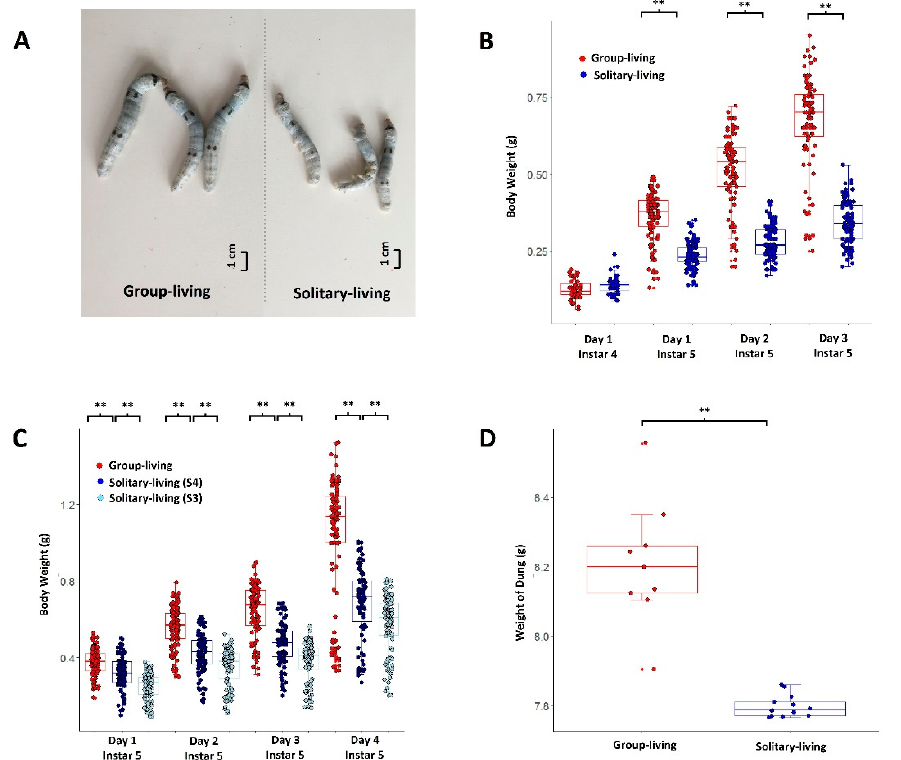
Figure 1. Evidence showing that solitary-living silkworms experienced a loss of body weight compared to group-breeding silkworms. ( A ) is a photo showing the difference in appearance of solitary and group-living silkworms in the 3rd day of the 5th instar. ( B ) shows the body weights of solitary (blue) and group-living (red) silkworms from the 1st day to the 3rd of the 5th instar. The weights on the 1st day of the 4th instar acts as a control for comparison. ( C ) is the comparison of